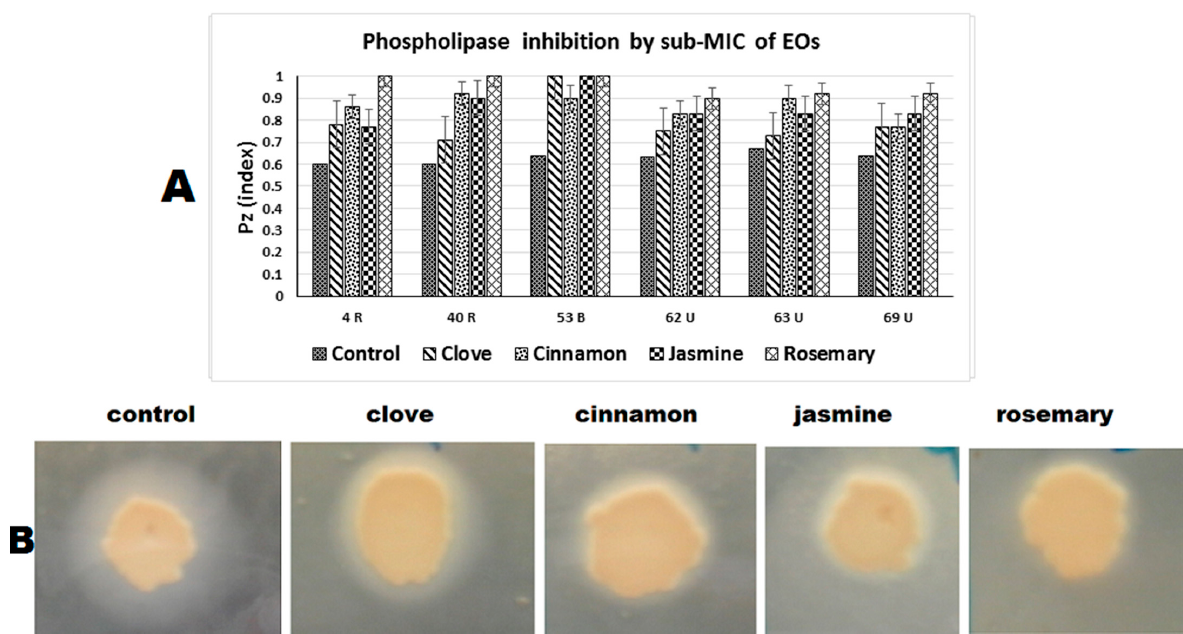
Figure 4. Phospholipase inhibition in C. albicans clinical isolates. ( A ) Graph showing changes in Pz value upon exposure to different EOs (the smaller the Pz value, the stronger the phospholipase activity and vice versa). ( B ) Representative images of phospholipase inhibition on egg-yolk agar containing sub-MIC of EOs.